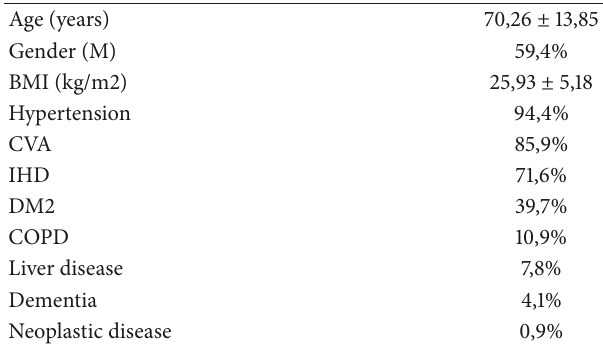
Table 1: Clinical characteristics.